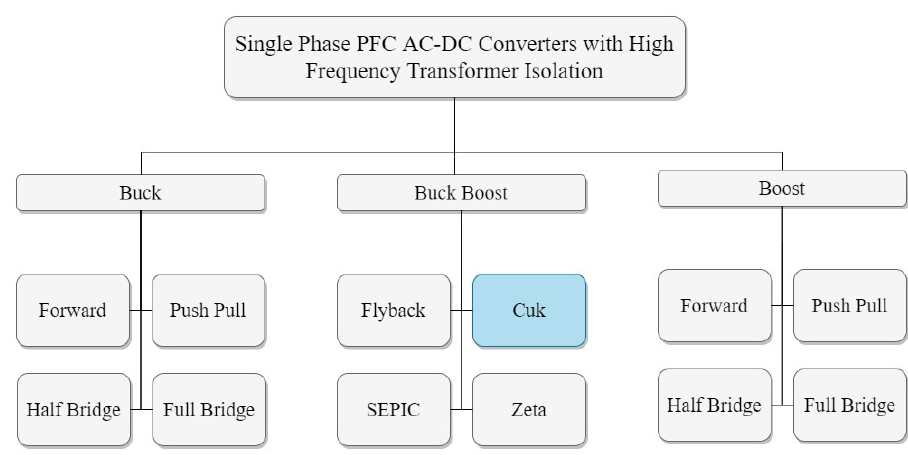
Figure 1. Classification of isolated power